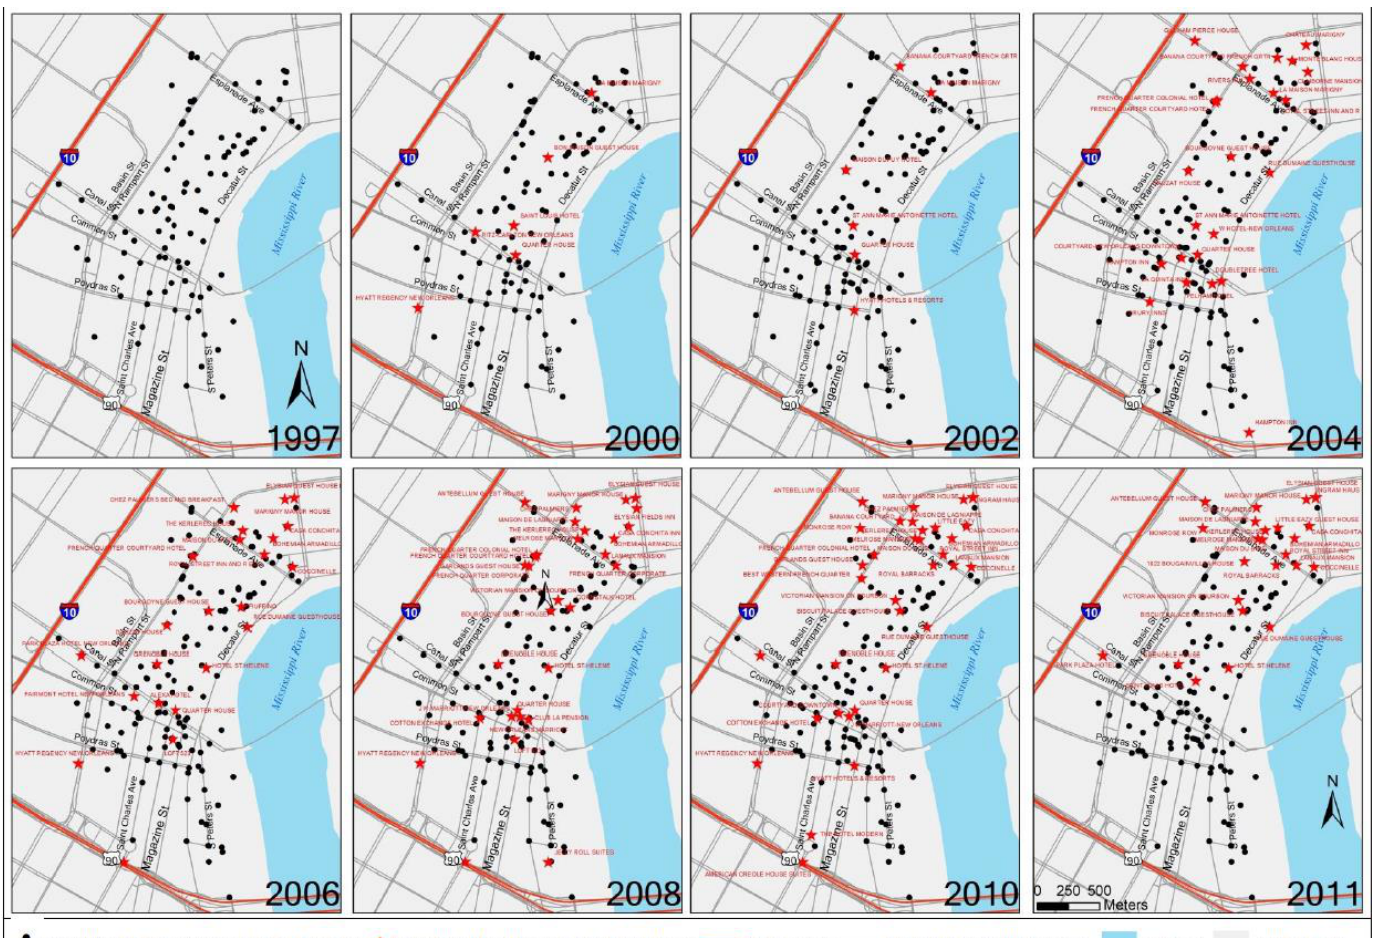
Figure 2. Original and updated hotels: New Orleans, LA, USA.